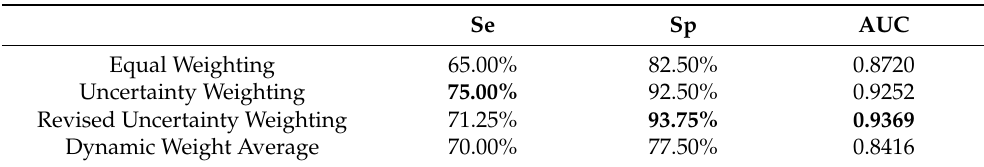
Table 2. Experiments on ways to weigh the main loss and the mask loss. Metrics ranked with 1st place are in bold.